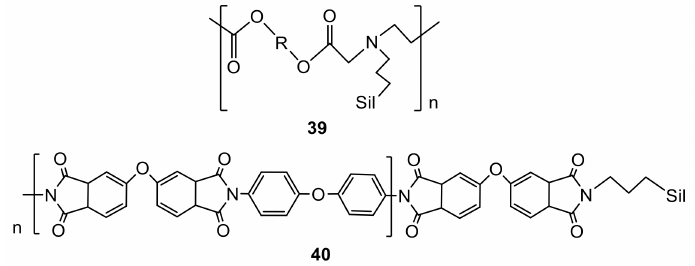
Figure 11. Chemical structures of silatranyl polymers and films ( 39 – 40